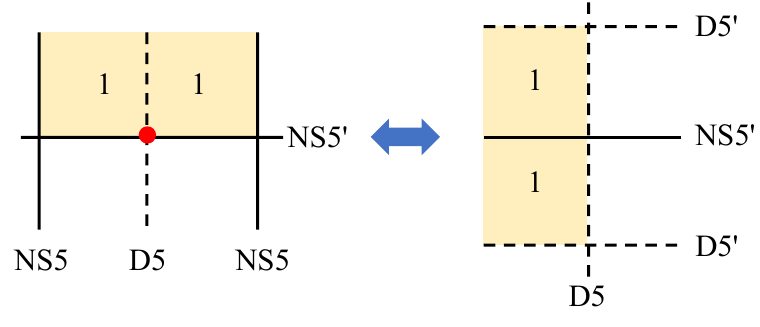
, N (cid:31) ) + Γ for SQED 1 and its dual N (cid:31)